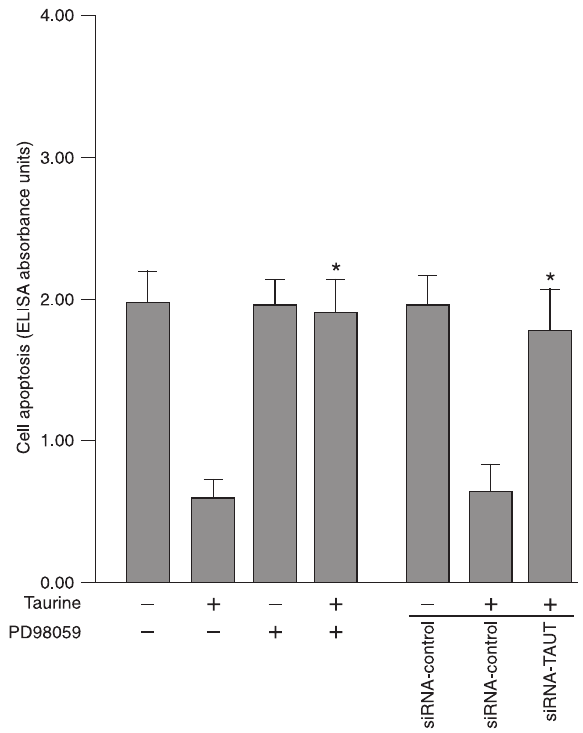
Figure 5. TAUT and ERK signaling pathways mediate the anti- apoptotic effect of taurine on MC3T3-E1 cells. Serum-deprived cells were incubated with 10 μM PD98059 for 3 h prior to treat - ment with 10 mM taurine for 48 h. Both siRNA-control- and siRNA-TAUT-transfected cells were cultured in serum-deprived media and treated with 10 mM taurine for 48 h. Cell apoptosis was determined with a Cell Death Detection kit, and reported as ELISA absorbance units. The bars indicate the mean ± SD (N = 5). TAUT = taurine transporter; ERK = extracellular signal- regulated kinase; siRNA = small interfering RNA. *P < 0.05 vs taurine-treated control (one-way